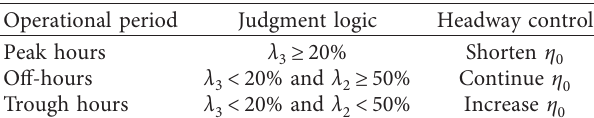
Table 4: The real-time judgment logic. Operational